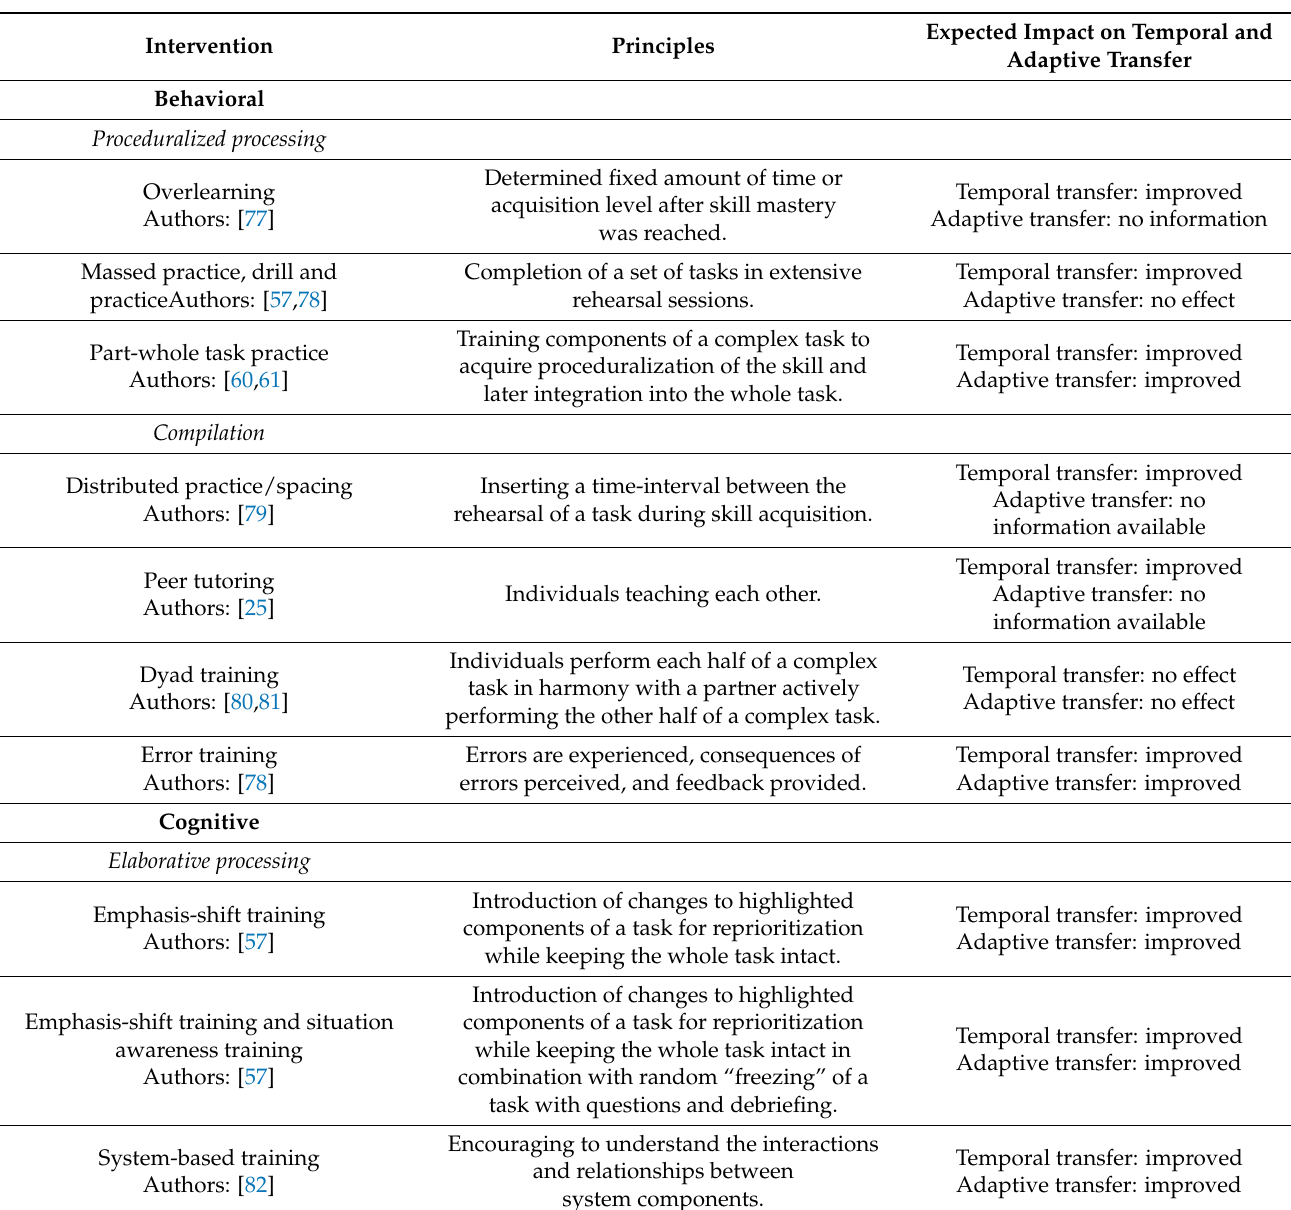
Table 5. Initial training: method-related factors for complex cognitive tasks and their impacts on temporal and adaptive